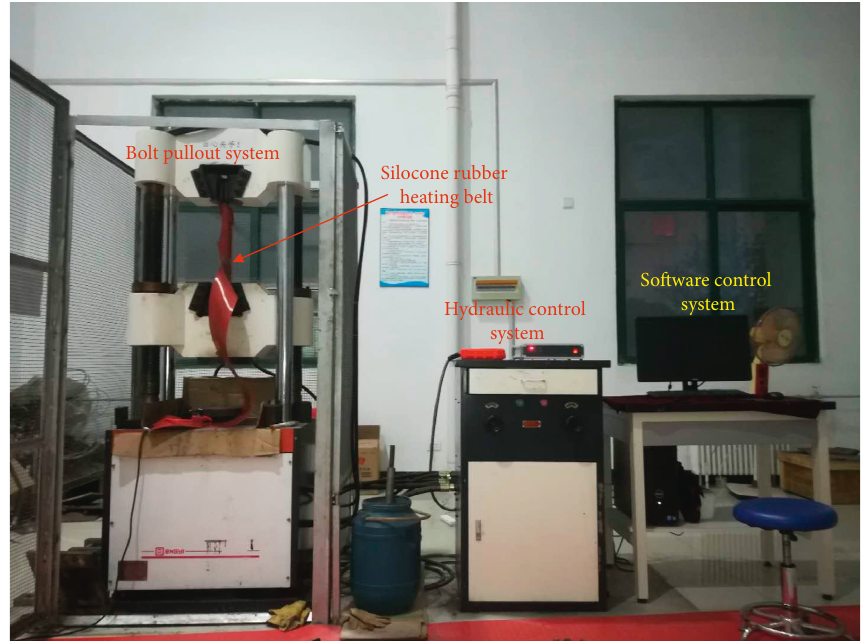
Figure 7: Test system for testing anchoring force.